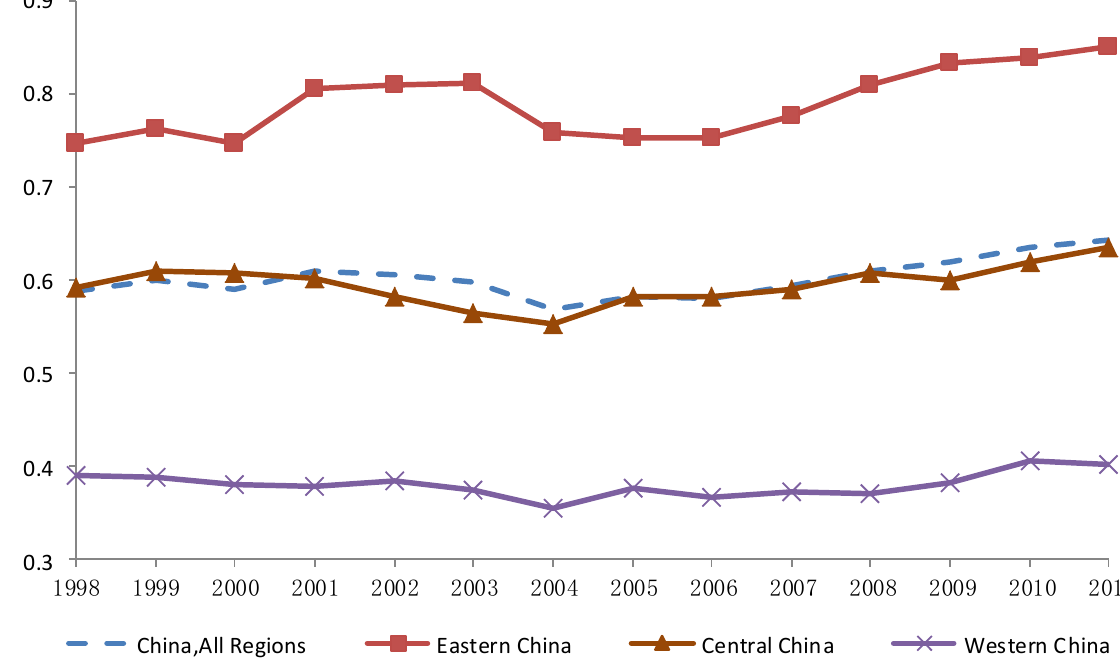
Figure 3. China’s regional energy efficiency